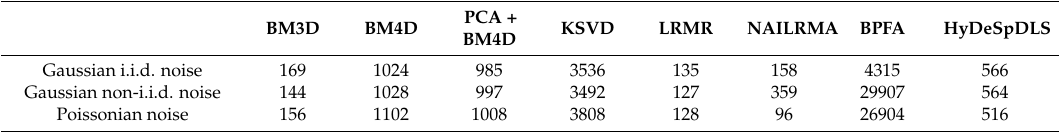
Table 2. Computational time (seconds) of different denoising algorithms applied to the Washington DC Mall